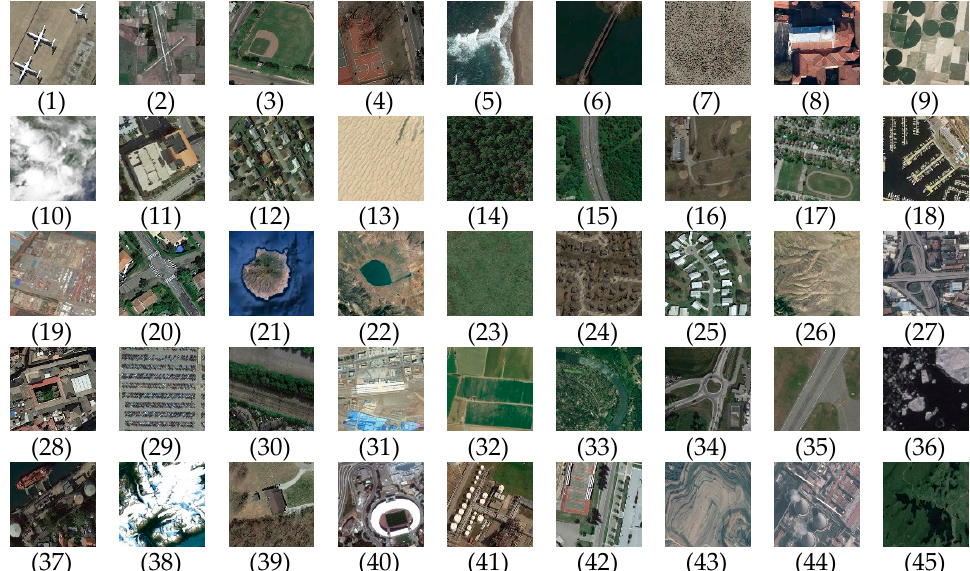
Figure 1. Examples from the NWPU-RESIST45 dataset: (1) airplane, (2) airport, (3) baseball dia- mond, (4) basketball court, (5) beach, (6) bridge, (7) chaparral, (8) church, (9) circular farmland, (10) cloud, (11) commercial area, (12) dense residential, (13) desert, (14) forest, (15) freeway, (16) golf course, (17) ground track field, (18) harbor, (19) industrial area, (20) intersection, (21) island, (22) lake, (23) meadow, (24) medium residential, (25) mobile home park, (26) mountain, (27) overpass, (28) palace, (29) parking lot, (30) railway, (31) railway station, (32) rectangular farmland, (33) river, (34) roundabout, (35) runway, (36) sea ice, (37) ship, (38) snowberg, (39) sparse residential, (40) sta- dium, (41) storage tank, (42) tennis court, (43) terrace, (44) thermal power station, (45) wetland. The SIRI-WHU dataset was collected and produced by the research team of Wuhan University, which contains 12 categories of scene images including farmland, business quarters, ports, idle land, industrial areas, grasslands, overpasses, parking lots, ponds, residential areas, rivers, and water. The representative images of each class are shown in Figure 2. Each class in the SIRI-WHU dataset consists of 200 optical aerial images with 200 × 200 pixels and a 2-m resolution. Dataset resources can be searched from Google Earth, mainly covering urban areas of China.